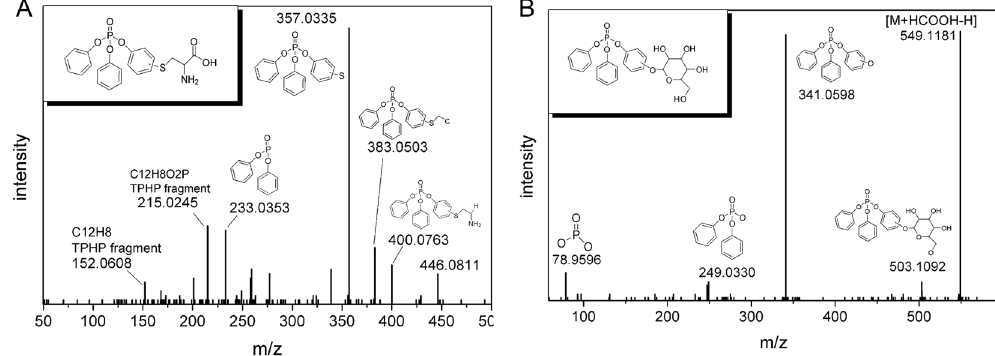
Figure 2. MS/MS spectrum of ( A ) cysteine-TPHP ( m/z 446.0811 in ESI + ) and ( B ) glucoside-TPHP ( m/z 549.1181 in ESI-) with annotation of the fragments. M refers to the intact metabolite.